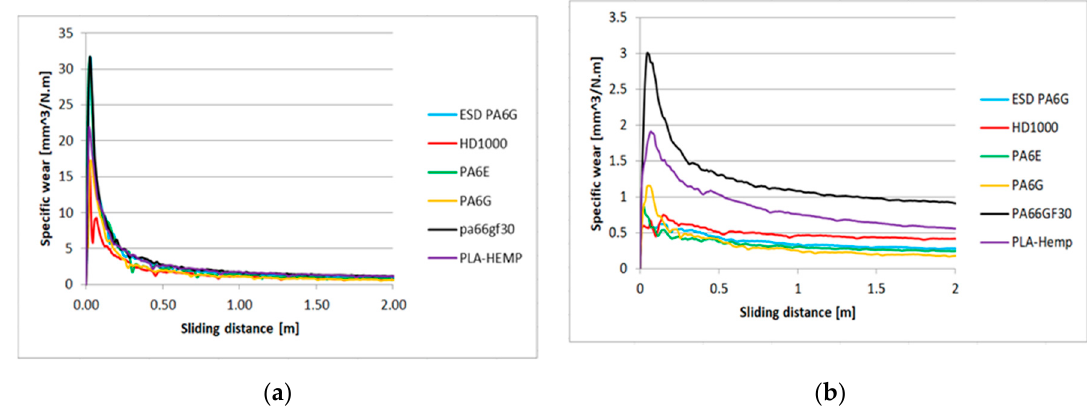
Figure 7. The relation between the specific wear and sliding distance for several polymers types on abrasive clothing” ( a ) lowest applied pv , ( b ) highest applied pv (Table 1).